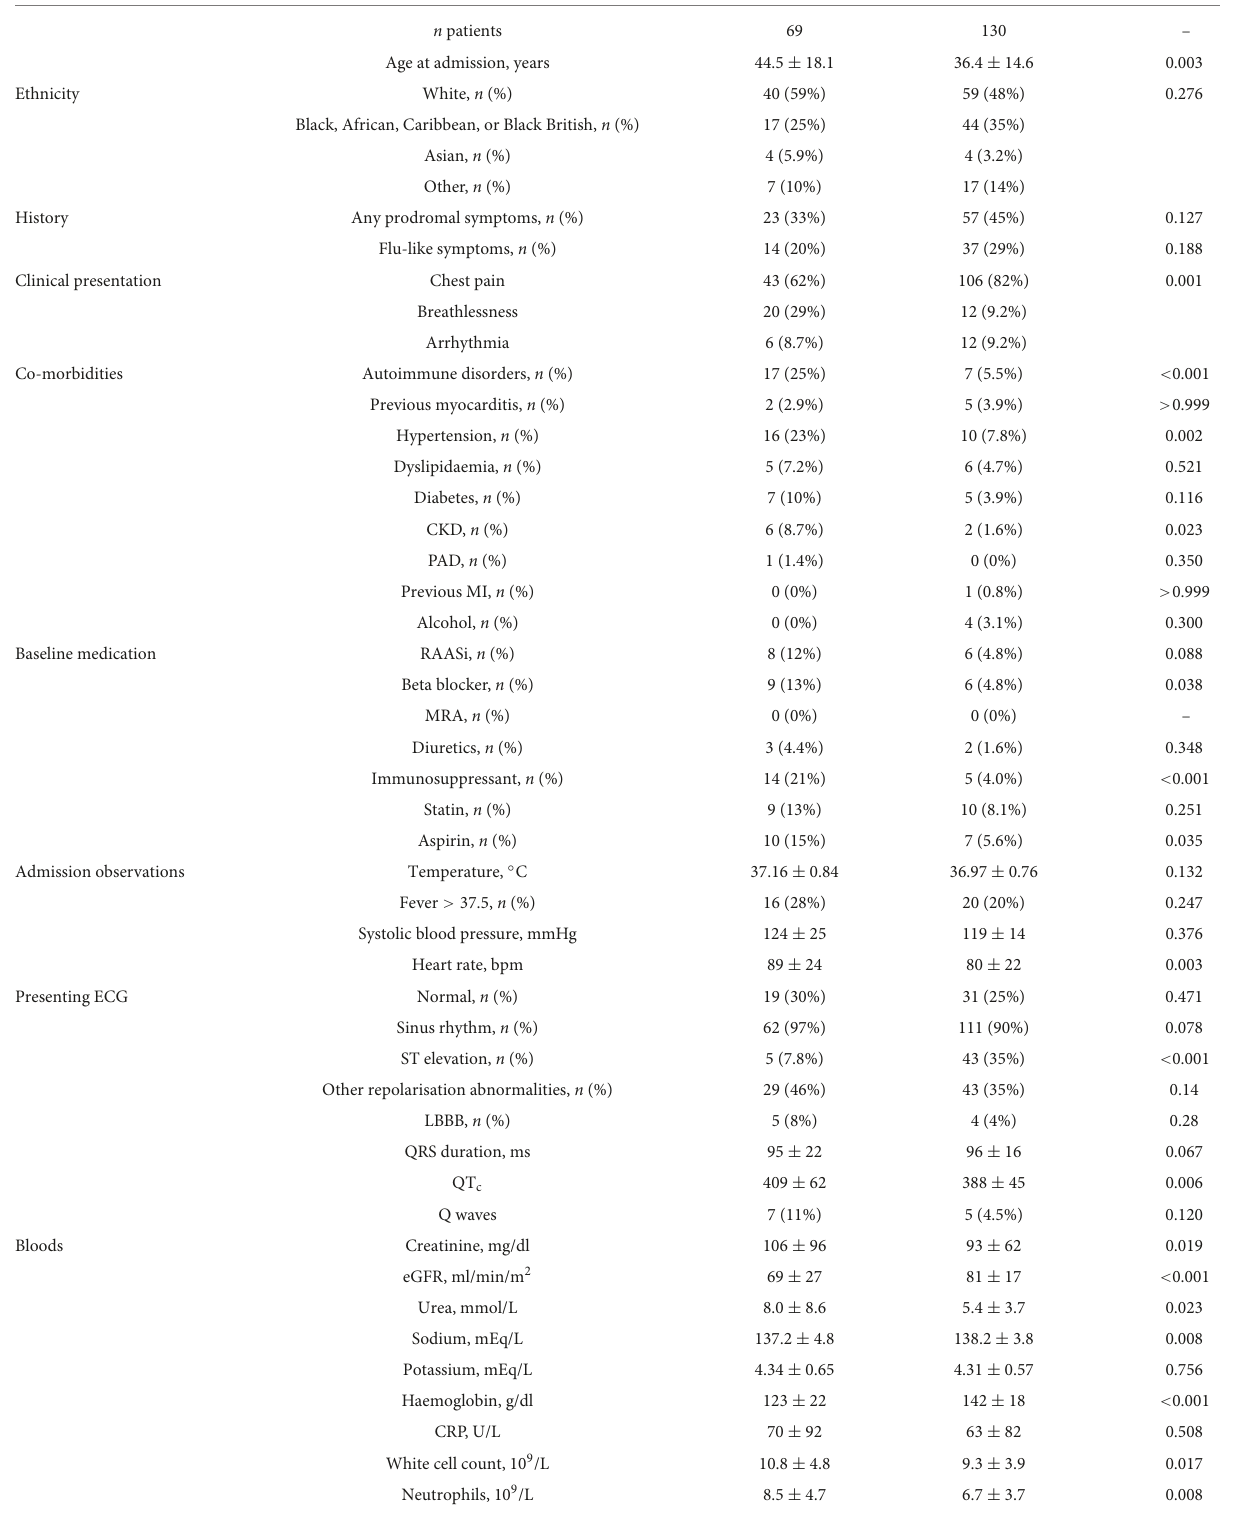
TABLE 4 Characteristics of study patients according to